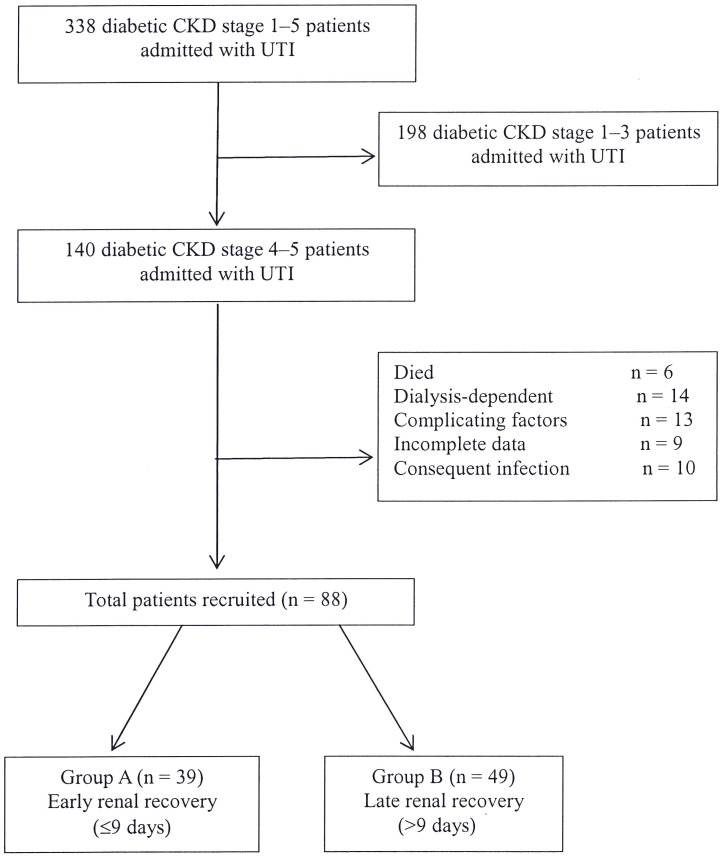
Participant flow diagram depicting the screening/enrollment process.